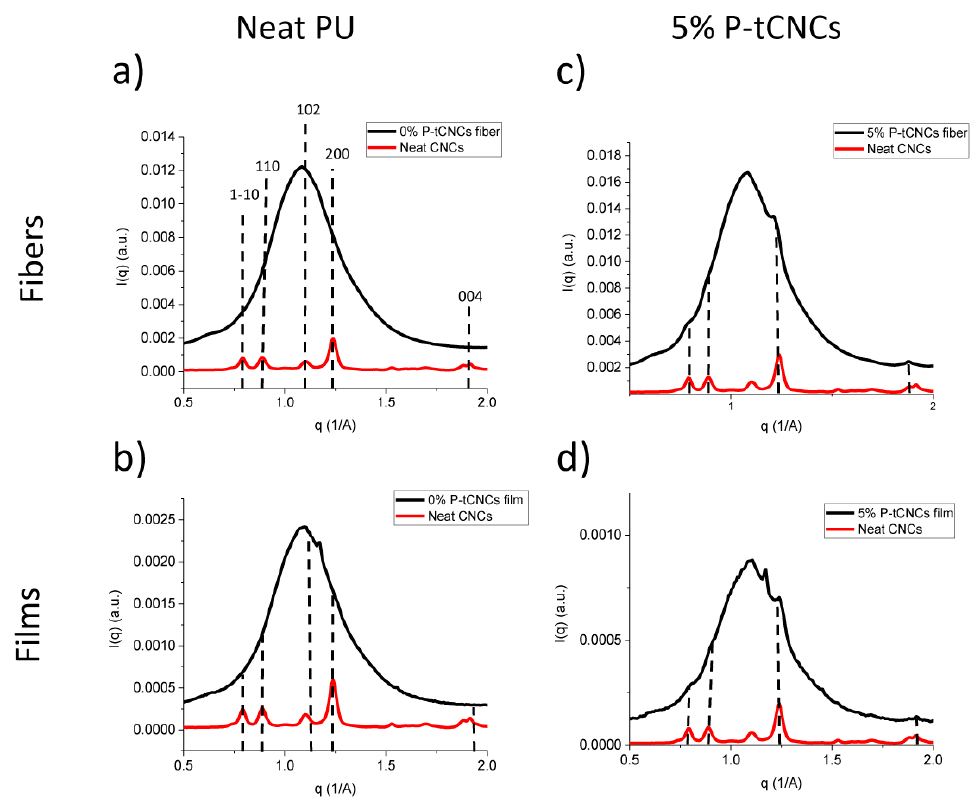
Figure 9. Azimuthal integration of WAXS patterns of ( a ) neat PU fibers, ( b ) neat PU films, ( c ) 5 wt% P-tCNC nanocomposite fibers, and ( d ) 5 wt% P-tCNC nanocomposite films.